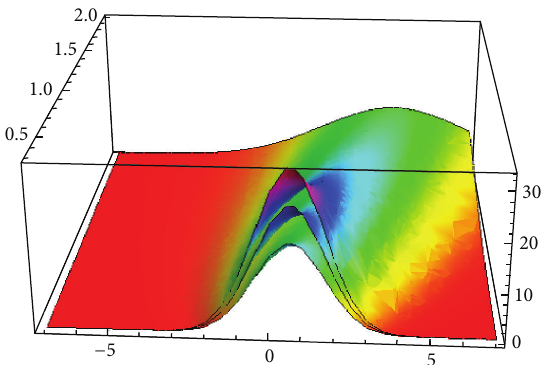
Figure 4: Graph of the fuzzy solution for 𝑏 = 0 .